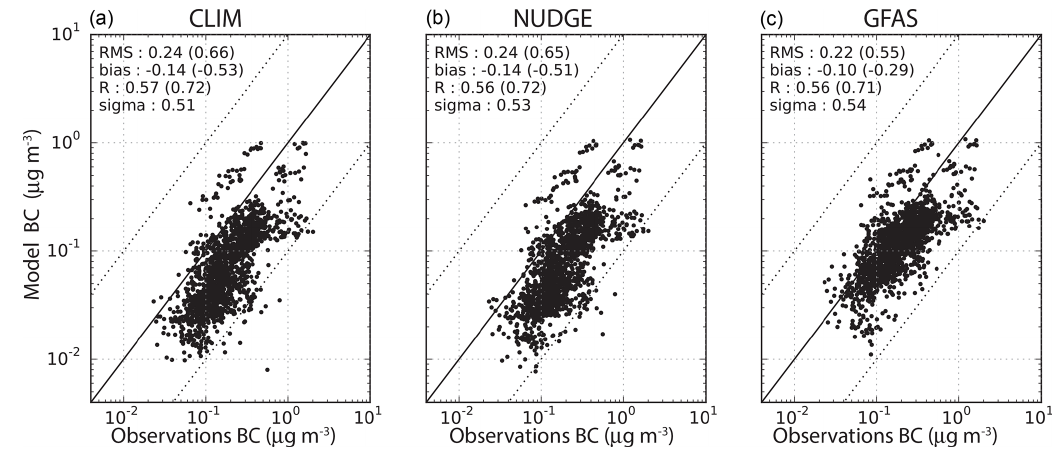
Figure 13. As Fig. 11 for black carbon (BC)